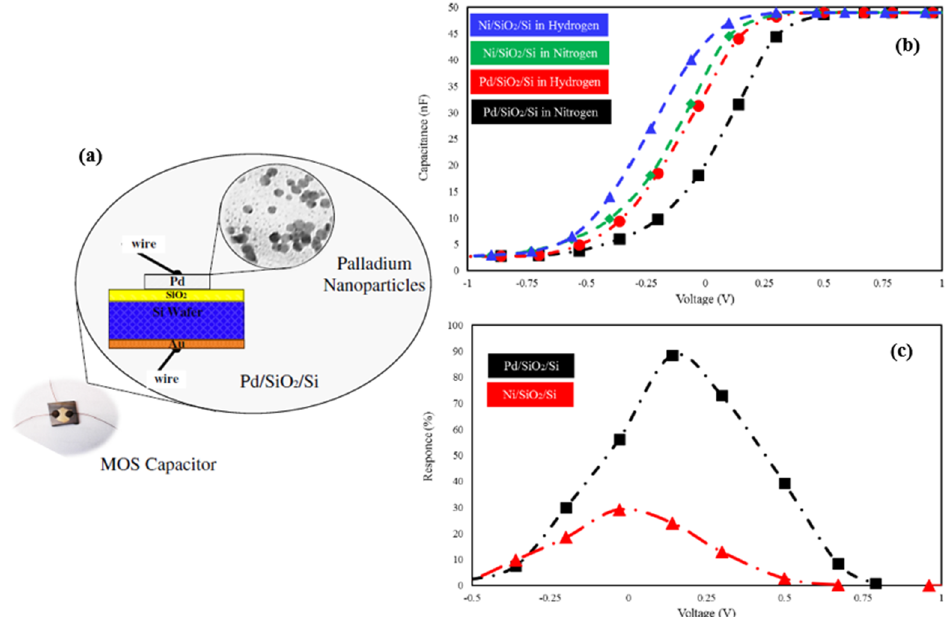
Figure 15. ( a ) Schematic diagram of the Pd/SiO 2 /Si capacitor. ( b ) Experimental values of the C–V curves for the Pd/SiO 2 /Si sensor at room temperature and the Ni/SiO 2 /Si sensor at 100 kHz frequency in a mixture of pure nitrogen and 1% H 2 –N 2 at 140 °C. ( c ) The response (%) of the Pd/SiO 2 /Si and Ni/SiO 2 /Si MOS capacitor sensors in 1% H 2 –N 2 mixtures [79]. Copyright (2017), with permission from World Scientific.